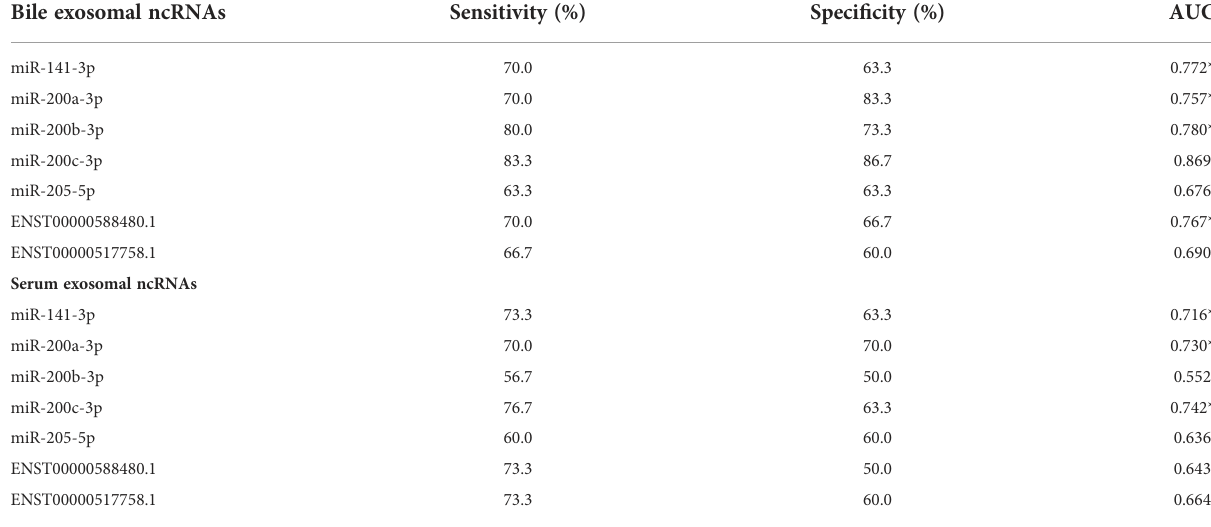
TABLE 3 Comparison of AUCs in the diagnosis of CCA. Bile exosomal